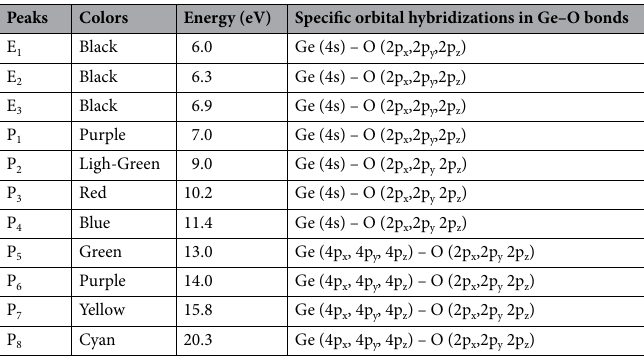
under the event of optical excitations 27 . Appar-